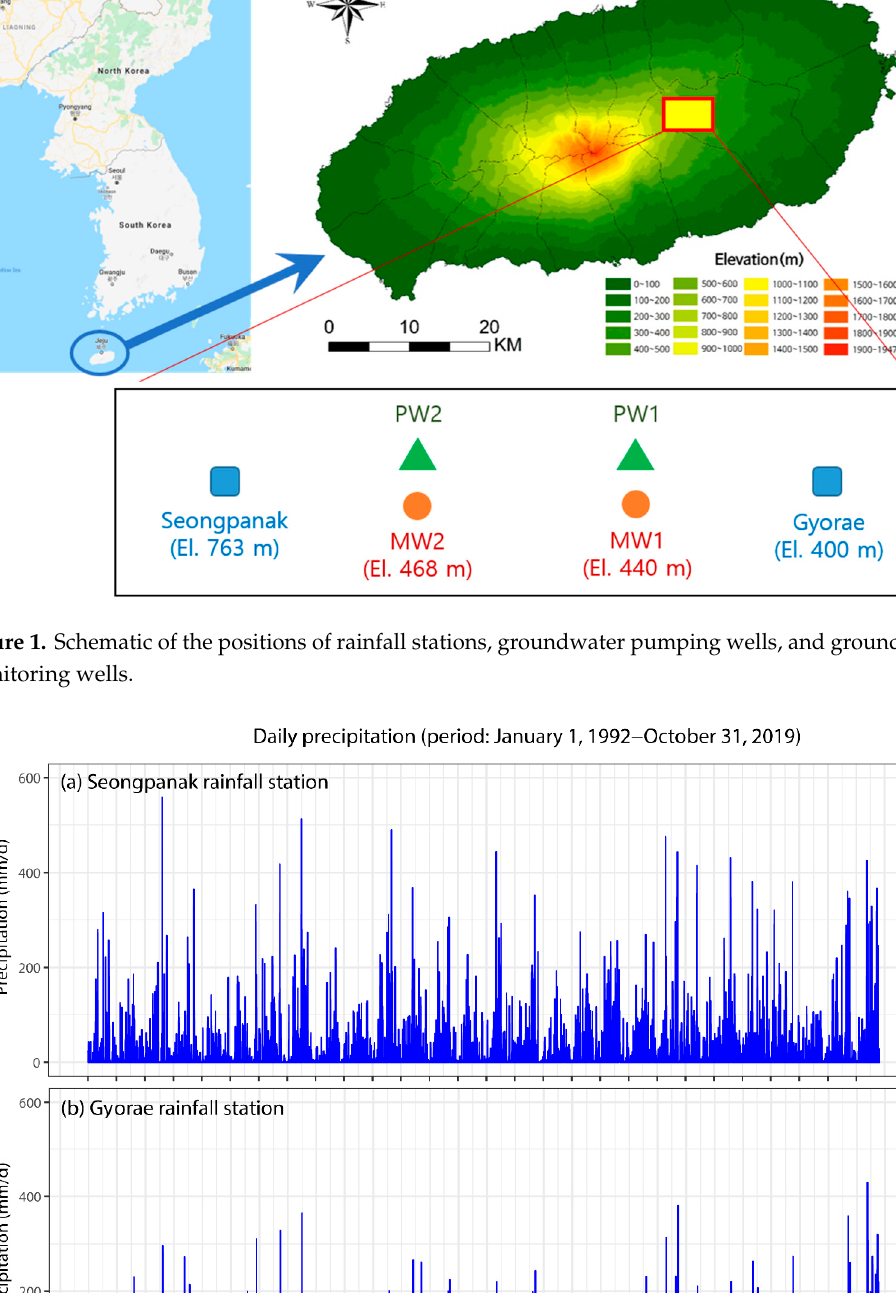
Figure 3. Boxplot for the variability of groundwater level in monitoring wells. 2.2. Long Short-Term Memory (LSTM) Long Short-Term Memory [15] is a modification of the RNN developed to solve the vanishing gradient problem [17], which makes it impossible for RNN to learn long-term dependencies. LSTM uses a conveyor belt (carry track, Figure 4) placed parallel to the sequence being processed so that the information from the sequence can be transported to the carry track at any point in time and then transported to a later time to be reused when needed. The information is stored in a carry track for later use, and therefore, there is no problem if the old signal gradually disappears during the calculation process [26]. LSTM was developed to remember long-term information and has a recurrent structure similar to the existing standard RNN, but the former differs from the latter in that